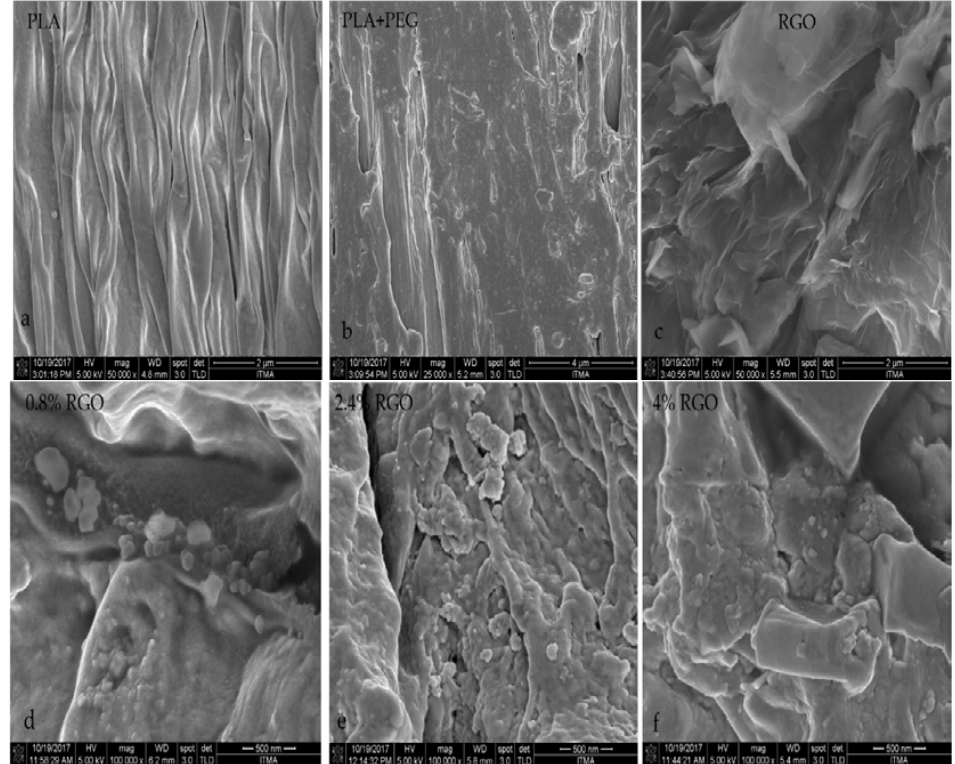
Figure 6. The field emission-scanning electron microscopy (FE-SEM) micrographs of the ( a ) pure PLA, ( b ) PLA/PEG mixture, ( c ) RGO powder with different RGO loadings of ( d ) 0.8%, ( e ) 2.4%, and ( f ) 4% RGO.